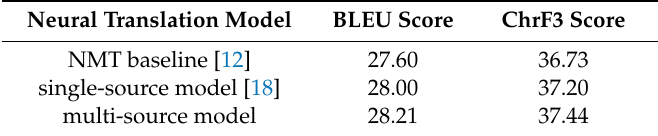
Table 6. The experimental results on Uyghur–Chinese machine translation task. 272